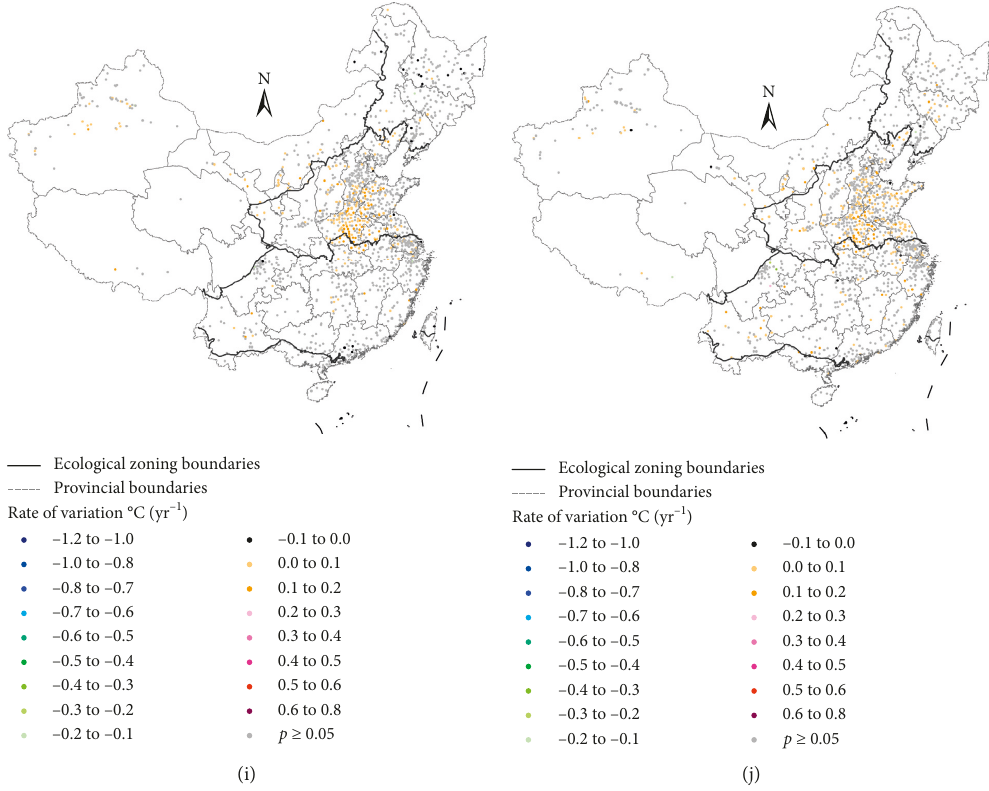
Figure 6: Spatial distribution of the annual and seasonal change rates of SUHIIs during the daytime and night-time from 2003 to 2013 in the five environmental regions of China: (a–e) the results during the whole year, winter, spring, summer, and autumn daytime, respectively; (f–j) corresponding values during night-time. (a) Annual day. (b) Winter day. (c) Spring day. (d) Summer day. (e) Autumn day. (f) Annual night.